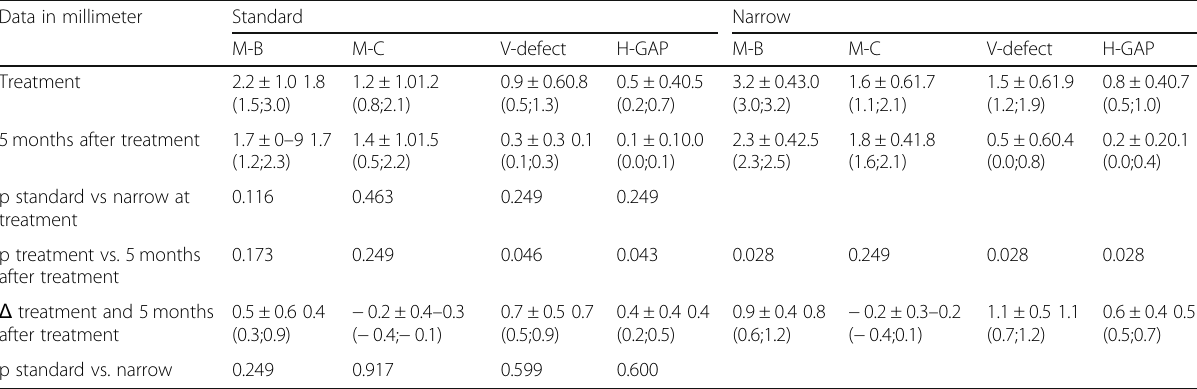
Table 1 Radiographic evaluation at the mesio-distal aspects. Mean values ± standard deviations and medians (25%;75% percentiles) of the two standard implants (3.8 mm and 4.25 mm) and of the two respective narrow implants (3.3 mm and 3.3 mm) at the time of treatment and after 5 months of healing. Differences ( Δ ) between periods and p values ( p < 0.05) are also reported. n =